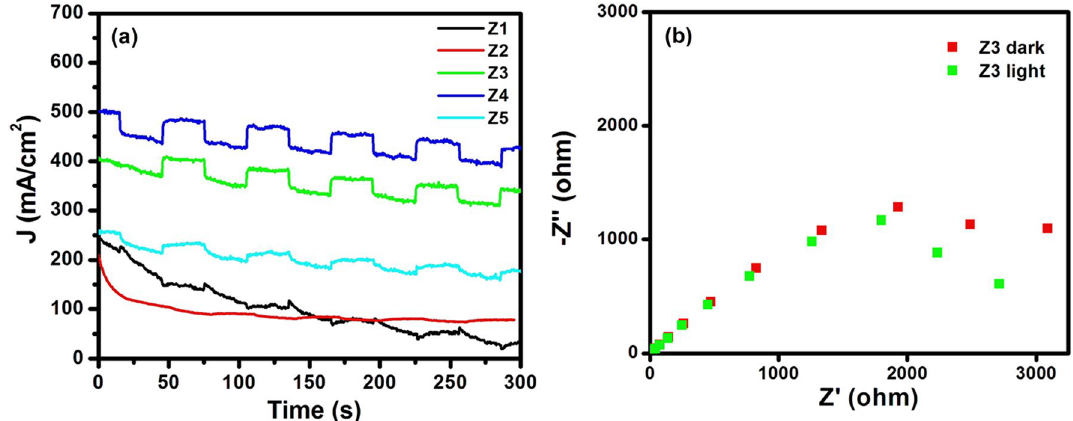
Fig. 12 a Transient photoresponse of ZnO–ZnS heterostructures and b EIS studies for Z3 in presence and absence of